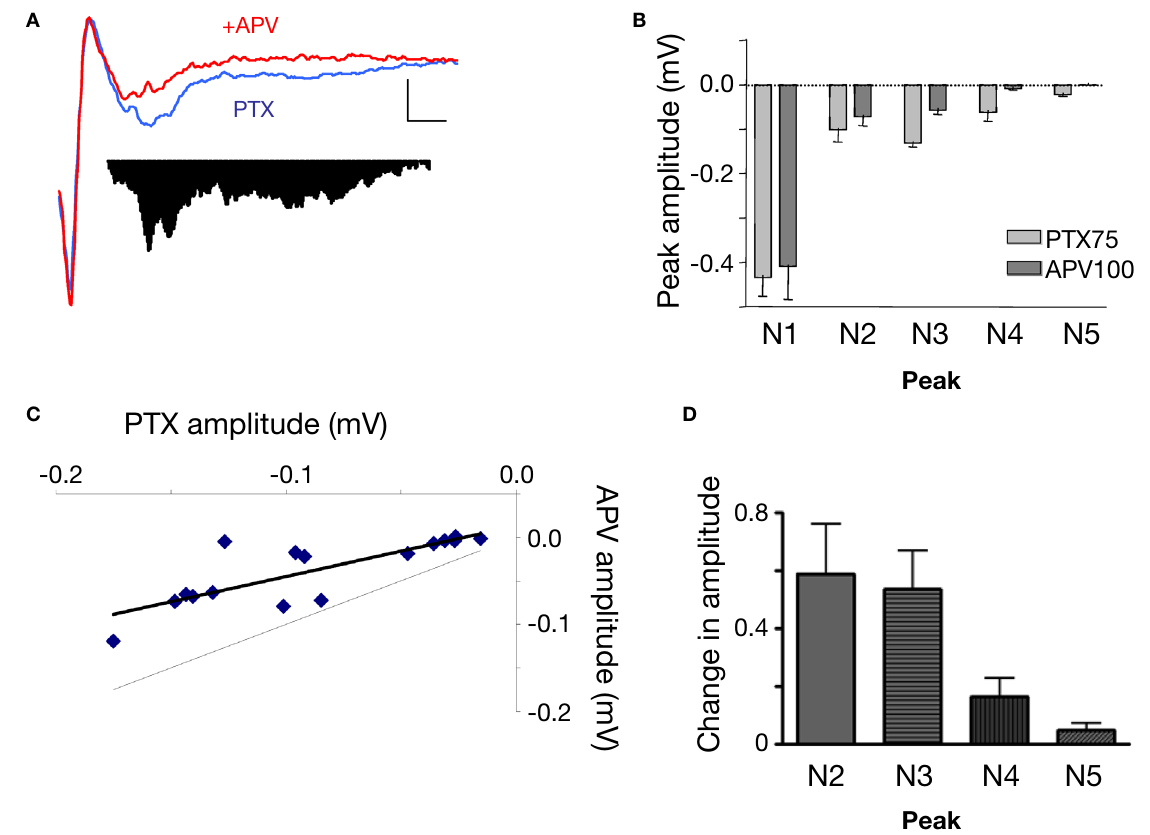
Figure 5 | Effect of NMDA antagonist APV (100 μ M) on polysynaptic activity in LAd-s. (A) Example traces, control (blue) and after added APV (red). The dif- ference in area under the trace of polysynaptic activity is also shown. (B) Mean peak amplitude was decreased [for N1–N5 peaks F (1,40) = 11.99, p < 0.002; post-hoc t -tests, N1 = ns; N2–N5 p < 0.05]. (C) All individual TLPs (N2–N5) were reduced (light line = no change) (D) Ratio of change in TLPs (N2–N5) indicating the change is non-uniform across TLPs [ F (3,16) = 4.7, p <